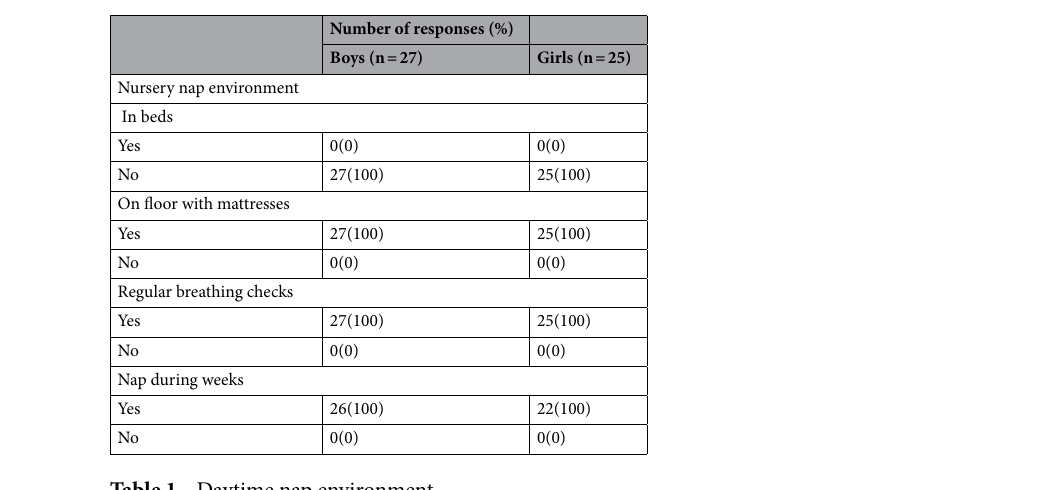
Table 1. Daytime nap